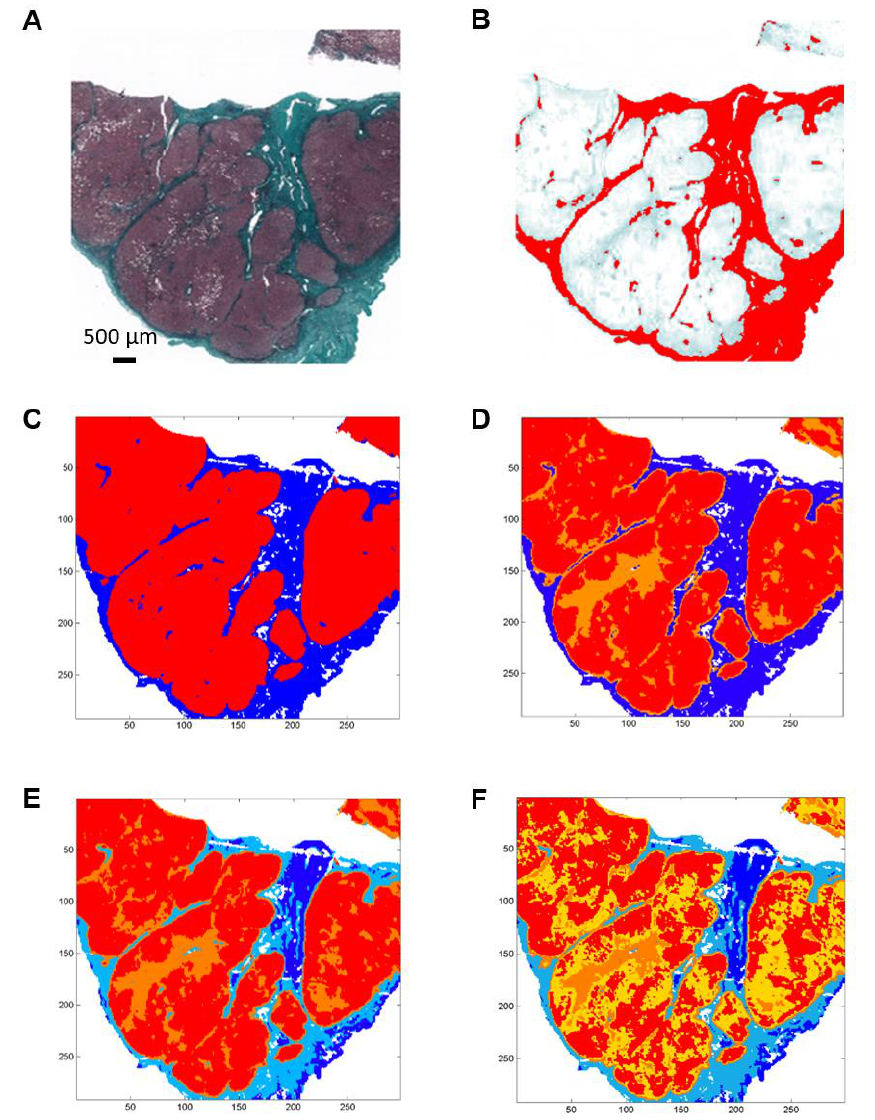
Figure 2. Example of histological and FTIR spectral images of a cirrhosis biopsy from a patient with hepatocellular carcinoma. ( A ) Histological section stained with Masson’s trichrome stain showing fibrosis in green. ( B ) Digital image analysis with fibrosis area in red. ( C – F ) K-means clustering of FTIR spectral images of an adjacent section in 2, 3, 4 and 5 clusters respectively from a 900–1800 cm −1 infrared absorbance dataset acquired with a projected pixel size of 25 µm. Clusters are displayed using random pseudo-colors. Fibrosis is represented by the dark blue cluster in C, D and in dark blue and light blue in E and F. Other colors correspond to regeneration nodules.